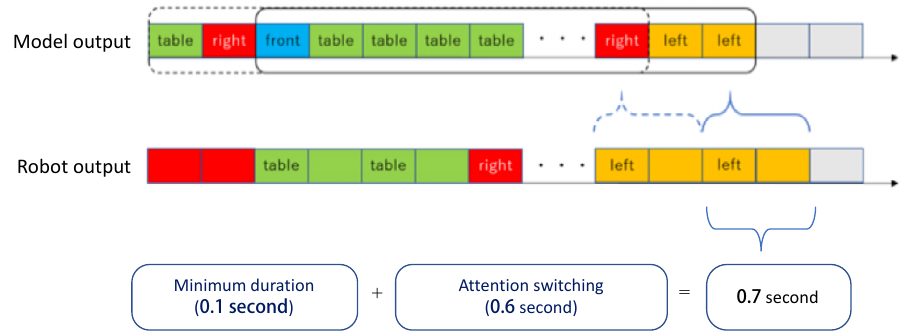
Figure 9. Conceptual diagram of the filtering from the outputs of attention model to actual robot movements.